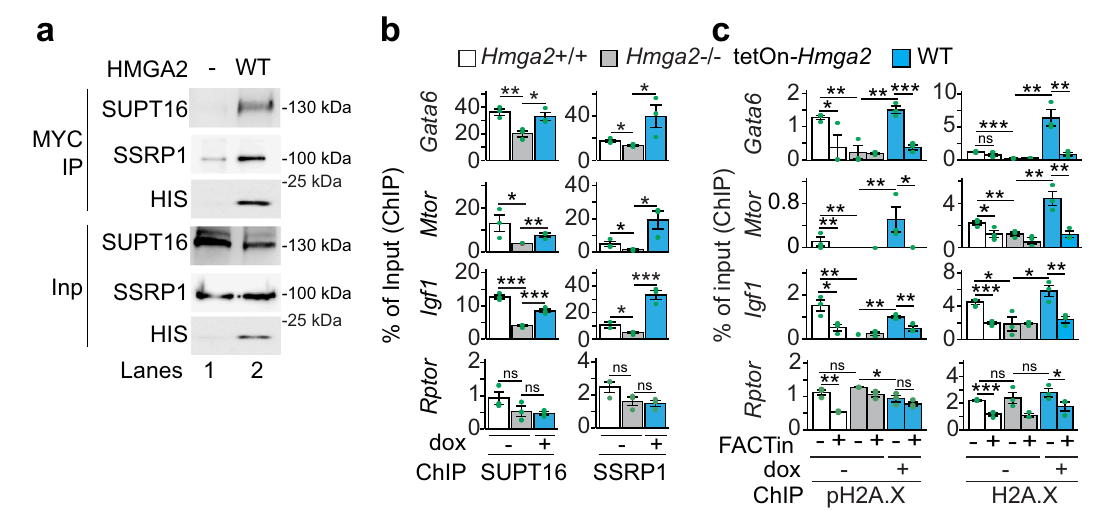
Fig. 5 HMGA2 -FACT interaction is required for pH2A.X deposition. a Western blot using the indicated antibodies after co-immunoprecipitation (Co-IP) assay using nuclear protein extracts from Hmga2 − / − MEF that were non-transfected ( − ) or stably transfected with Hmga2-myc-his (WT) and magnetic beads coated with MYC-speci fi c antibodies. Representative images from three independent experiments. Input, 5% of IP starting material. b , c ChIP-based promoter analysis of selected HMGA2 target genes using the indicated antibodies and chromatin from Hmga2 + / + , Hmga2 − / − MEF, as well as Hmga2 − / − MEF that were stably transfected with a tetracycline-inducible expression construct (tetOn) for WT Hmga2-myc-his . MEF were treated with doxycycline and FACT inhibitor (FACTin; CBLC000 tri fl uoroacetate) as indicated. In all bar plots, data are shown as means ± s.e.m. ( n = 3 biologically independent experiments); asterisks, P- values after one-tailed t -Test, *** P ≤ 0.001; ** P ≤ 0.01; * P ≤ 0.05; ns, non-signi fi cant. See also Supplementary Fig. 5. Source data are provided as a Source Data fi les 01 and